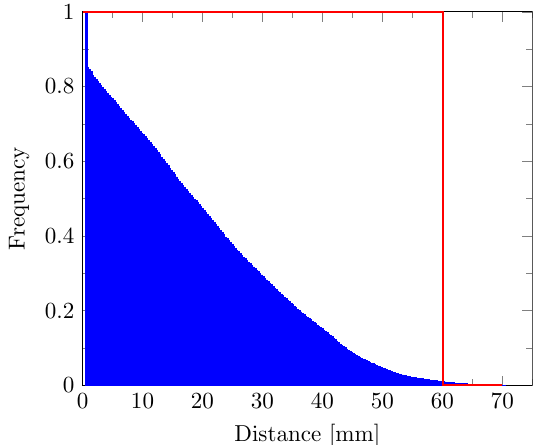
Figure 6. Inverse cumulative distribution of the geodesic distance values along the edema outlines. The expected distribution under the hypothesis of iso-distance edema outlines is plotted in red.